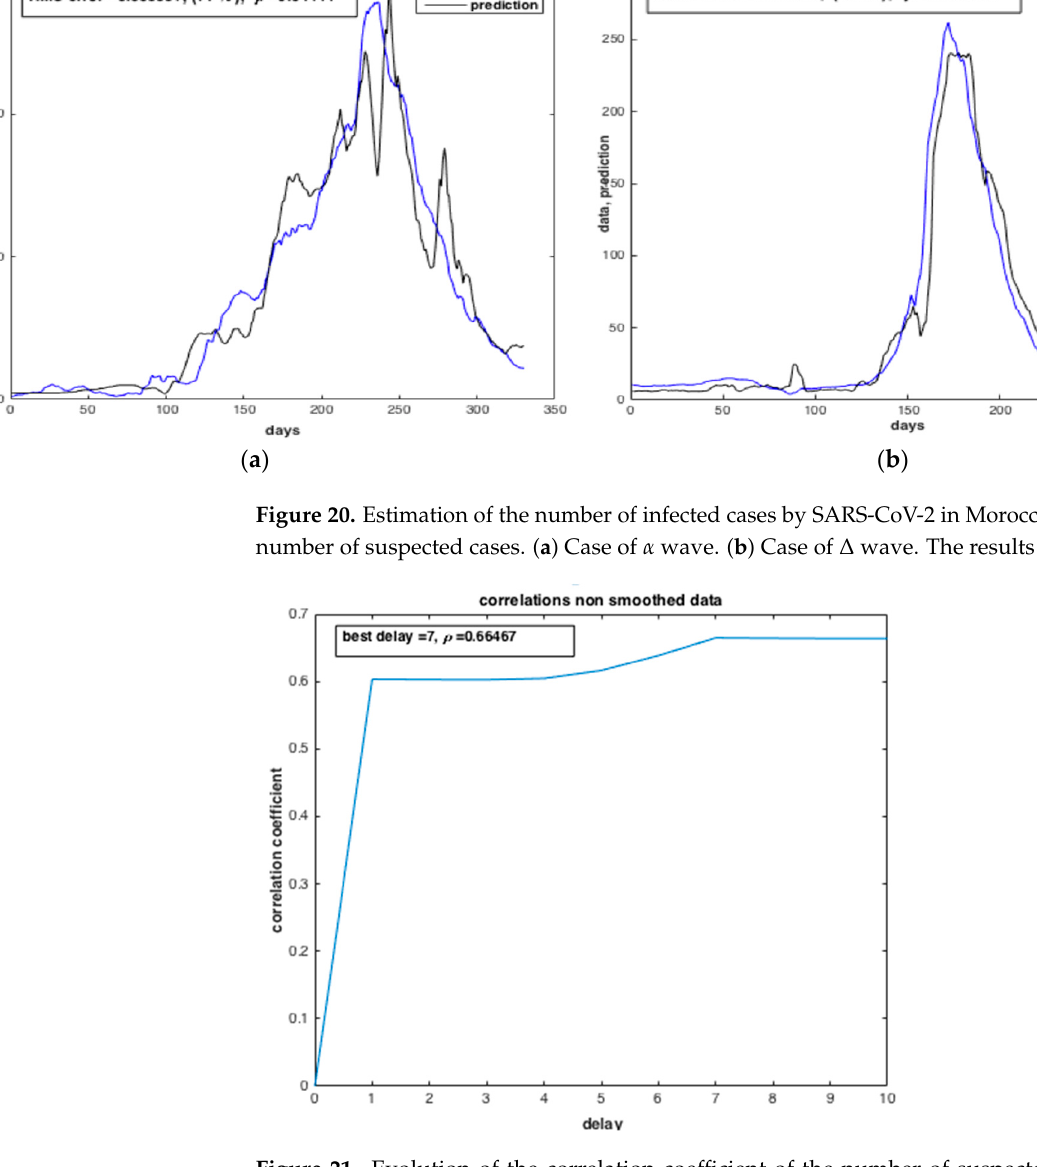
Figure 21. Evolution of the correlation coefficient of the number of suspected cases (S) and the num- ber of infected cases (I).